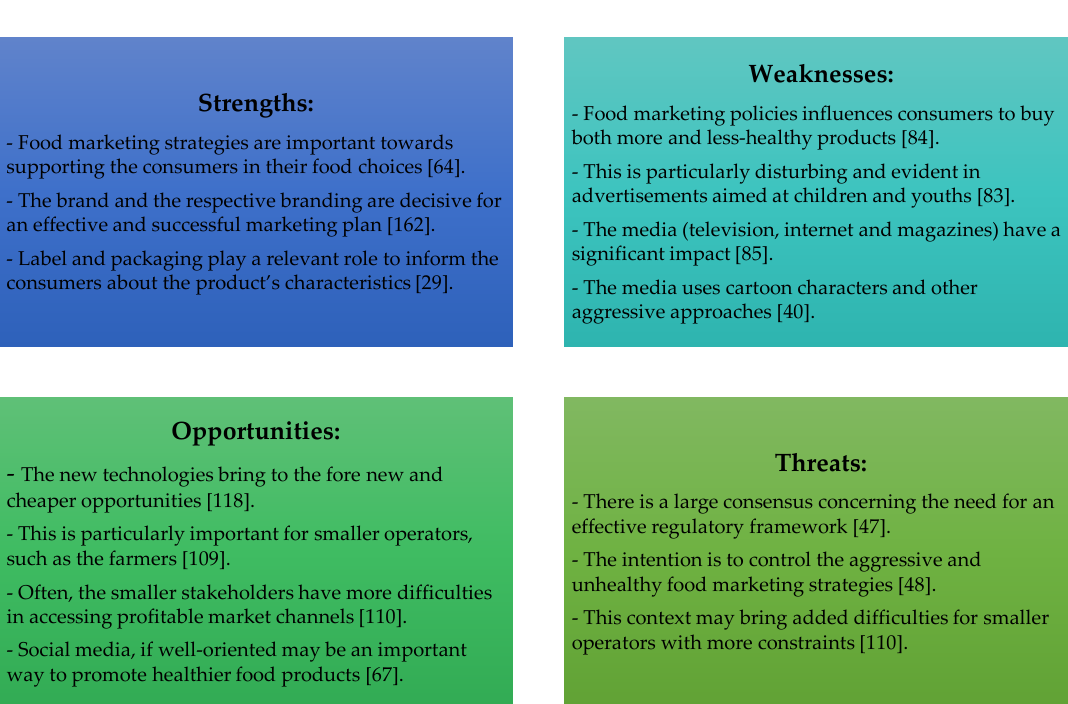
Figure 6. SWOT (strengths, weaknesses, opportunities, and threats) analysis to summarise the literature review.